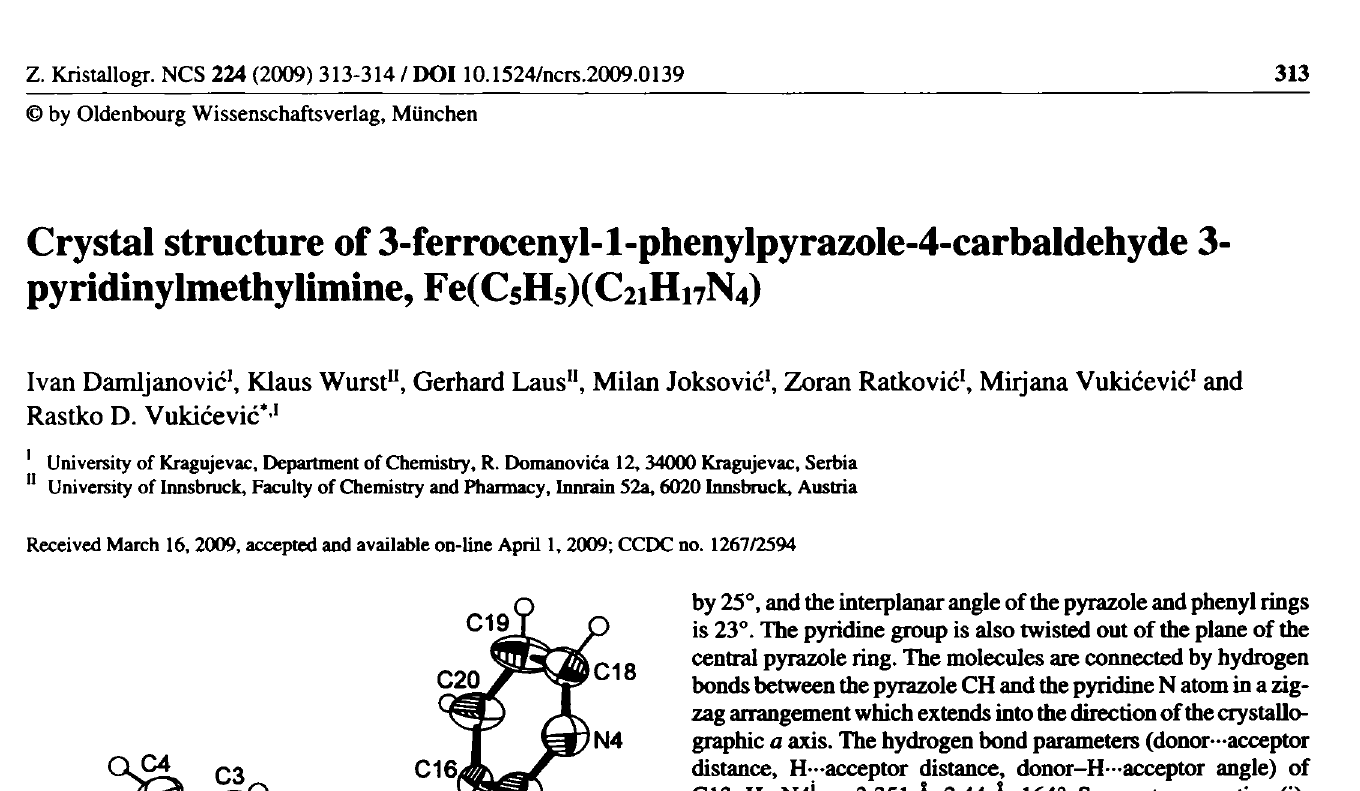
Table 1. Data collection and handling.